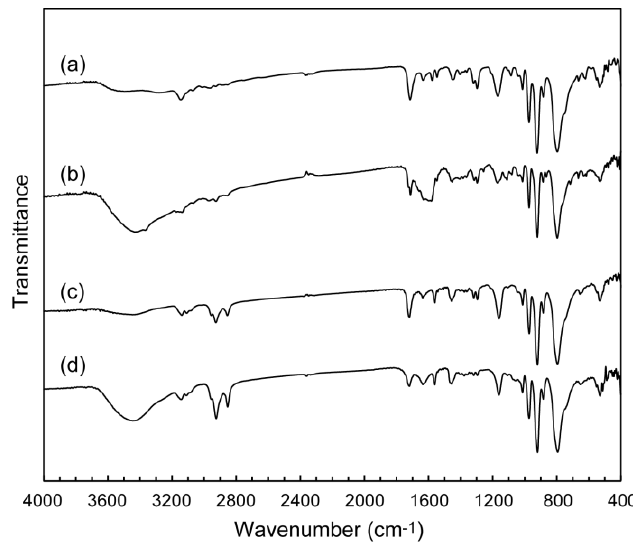
Figure 5. IR spectra of Mo 8 hybrid crystals: ( a ) as-prepared 3 ; ( b ) recrystallized 3 ; ( c ) as-prepared 4 ; ( d ) recrystallized 4 .